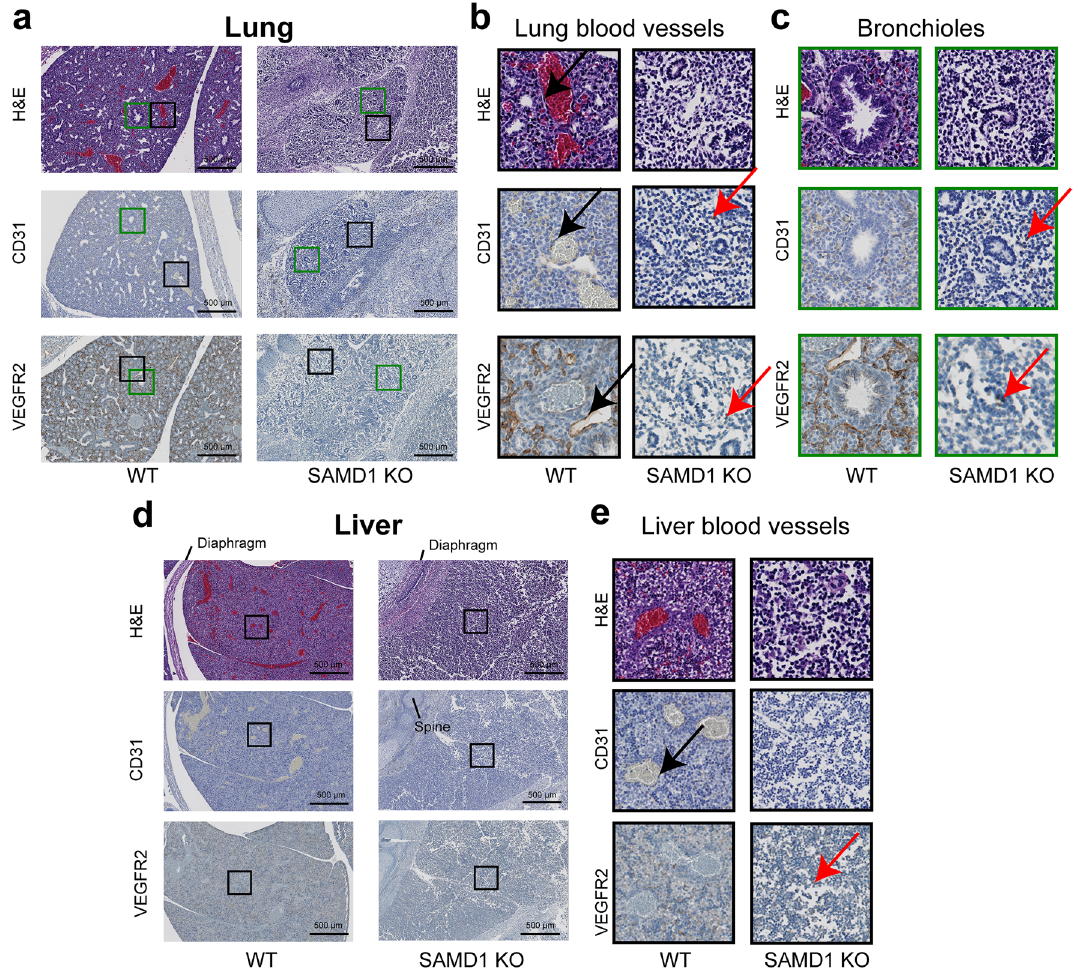
Figure 4. Absence of blood vessels in the lung and liver of SAMD1 KO embryos. ( a ) Macroscale microscopy of the lungs from wild-type and SAMD1 KO mice at E14.5 using H&E, CD31 (brown), and VEGFR2 (brown) staining. ( b ) Higher magnification of lung wild-type blood vessels; the black arrows point to spindle-shaped vascular smooth muscle cells (VSMCs) adjacent to ECs, that are not present in the KO lung. ( c ) Higher magnification of bronchioles, which are smaller and/or degraded in the KO mice. The lung appears to be fragmenting along the paths of failed vessels. ( d ) Macroscale microscopy of the lungs from wild-type and SAMD1 KO mice at E14.5 using H&E, CD31, and VEGFR2 staining. ( e ) Higher magnification of blood vessels in the wild-type liver, and their absence in the KO. The KO liver also appears to be fragmenting. Red arrows in b, c, and e indicate possible fragments of phagocytized